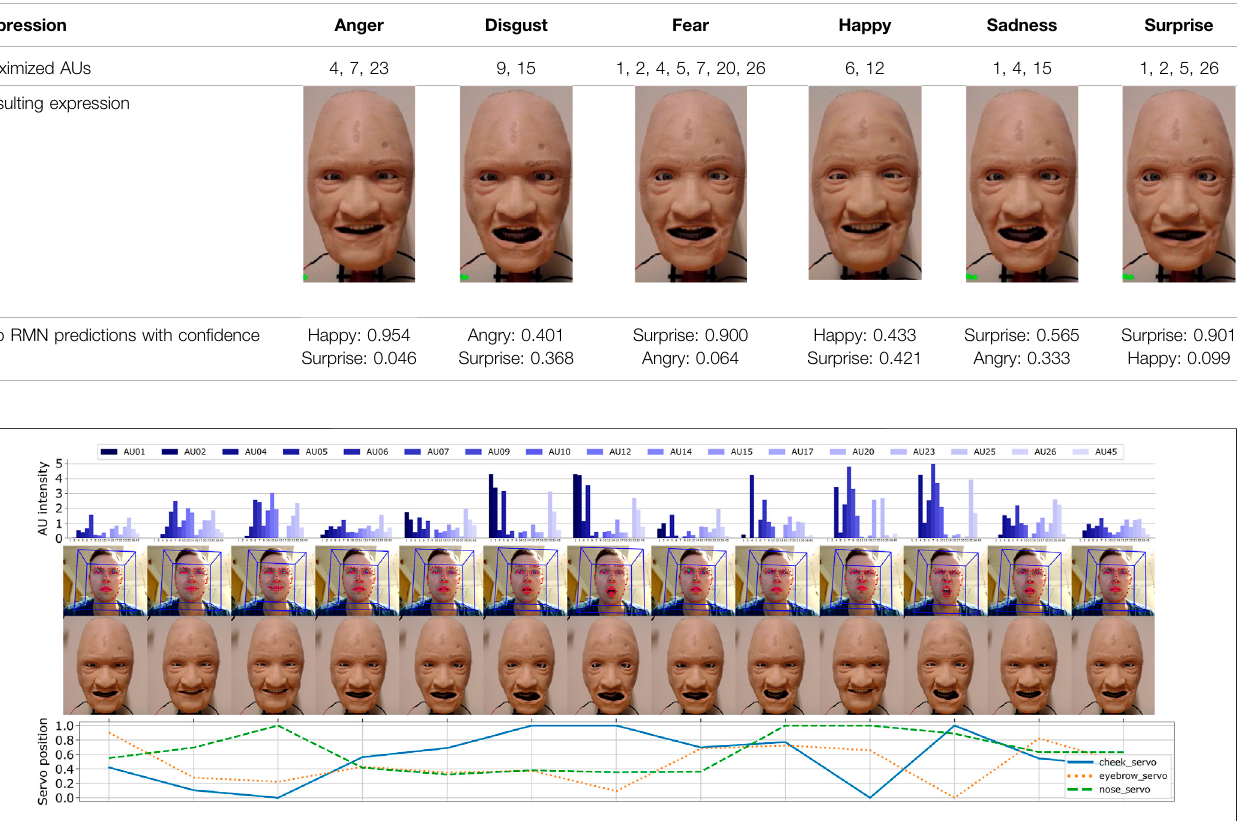
FIGURE 9 | Real-time reenactment using recorded AUs from a human actor to predict the servo